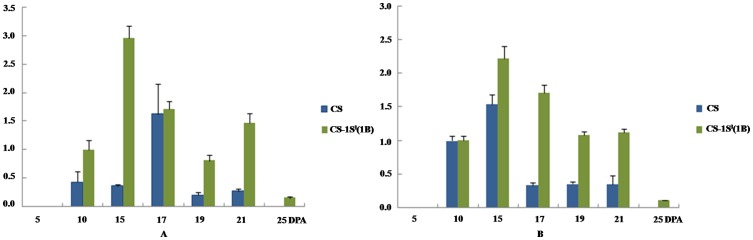
Expression patterns of HMW-GS genes in CS and CS-1Sl(1B) by qRT-PCR. A. x-type HMW-GS genes; B. y-type HMW-GS genes.